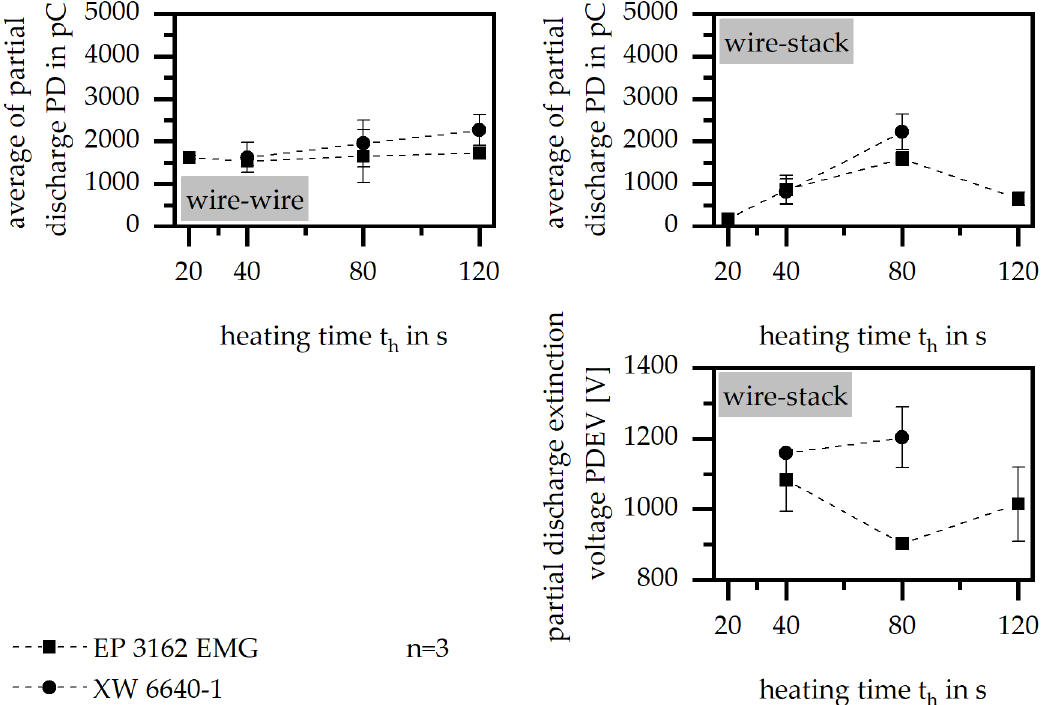
Figure 7. Average of partial discharge (PD) and partial discharge extinction voltage (PDEV), relative to the heating time in the insulation system of wire to wire and wire to stack.